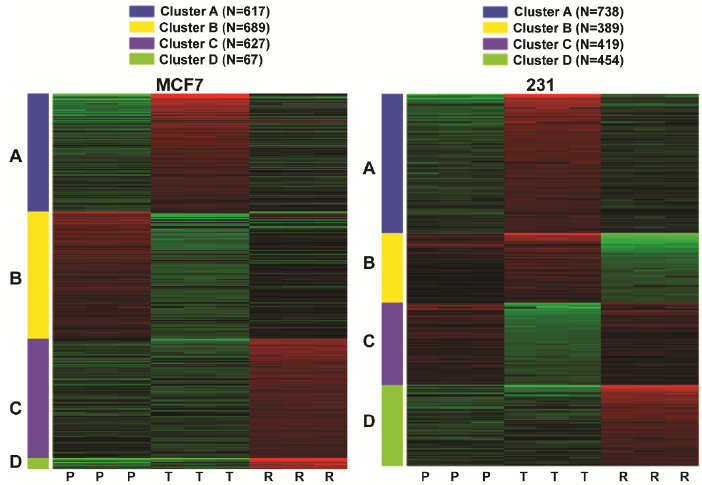
Figure 2. Three-way comparison of RNA-Seq gene expression analysis in parental (P), NB73 short- term treated (T), or NB73 resistant (R) cells. MCF7 P or 231 P cells were short-term treated with 4 µM NB73 (T) or Vehicle (P) for 24 h; MCF7 R or 231 R cells were continued in their maintenance dose of 10µM NB73. Heatmaps show genes with >2-fold expression changes and FDR < 0.05 in differential gene expression analysis. iDEP and K-means clustering analysis revealed four distinct clusters and patterns (A–D) of gene regulations in parental cells (P) versus treated (T) versus cells resistant (R) to NB73. Three parental, three treated, and three resistant samples were analyzed for each cell type. Table 1. Hallmark pathways associated with K-means gene expression clusters A–D in parental, treated, and resistant breast cancer cells. MCF7 231 Cluster Adj. p -val. #Genes Cluster Adj. p -val.